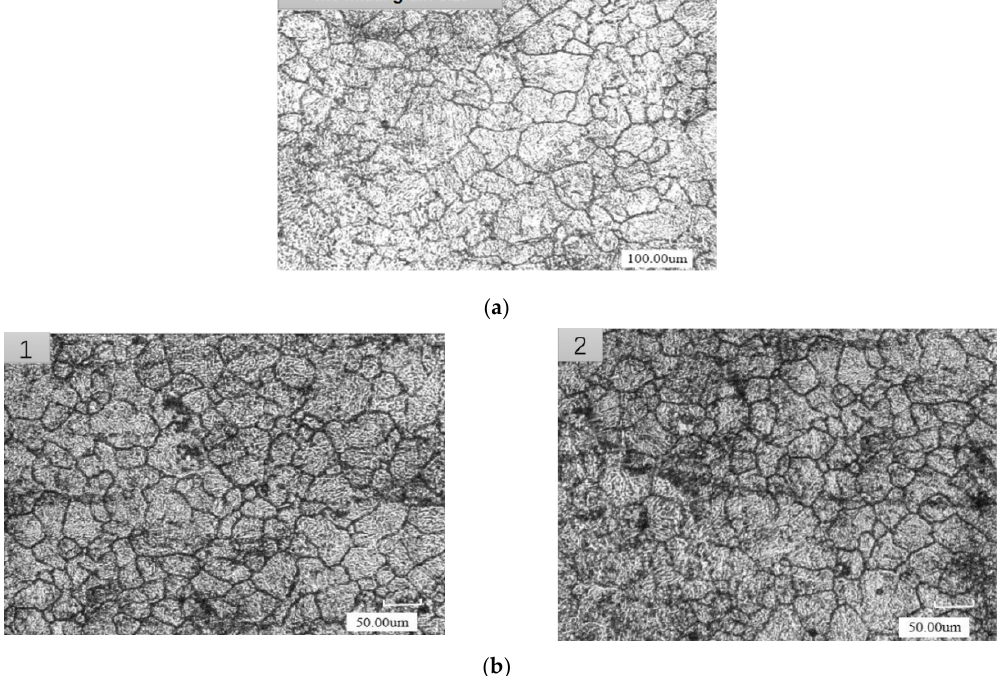
Figure 15. Grain size diagrams of steel ball before and after FPM. ( a ) The initial grain size; ( b ) Grain size after floating pressure method, ( 1 ) 10mm cube sample from Φ 42 specimen; ( 2 ) 10 mm cube sample from Φ 62 specimen.